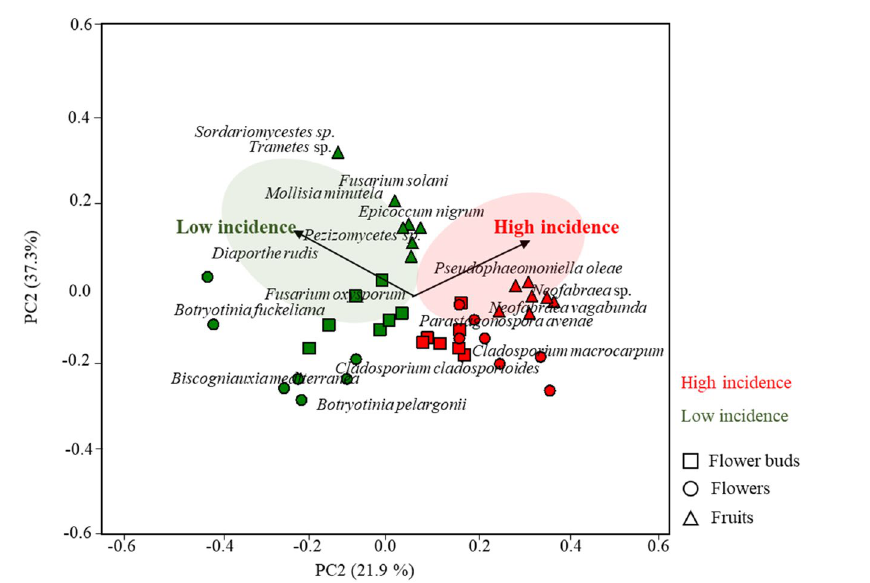
Figure 4. Frequency of colonization (%) of fungal endophytes in flower buds, flowers and fruits of olive tree growing in orchards with high (High incidence) and low (Low incidence) incidence of olive anthracnose.